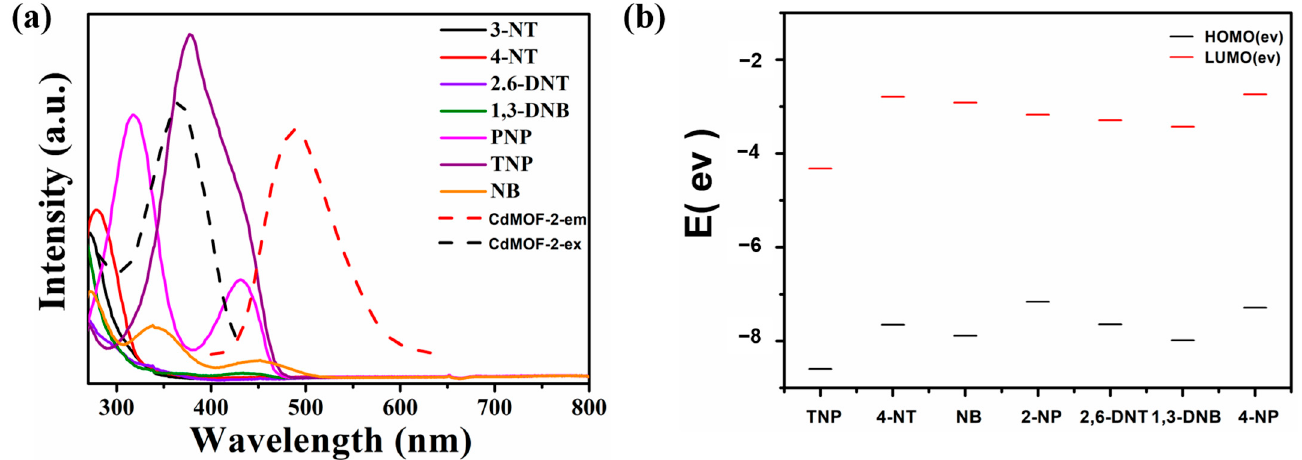
Figure 7. ( a ) The emission and excitation spectra of CdMOF-2 and absorption spectra of NACs in DMF solution. ( b ) HOMO and LUMO energy level of NACs.